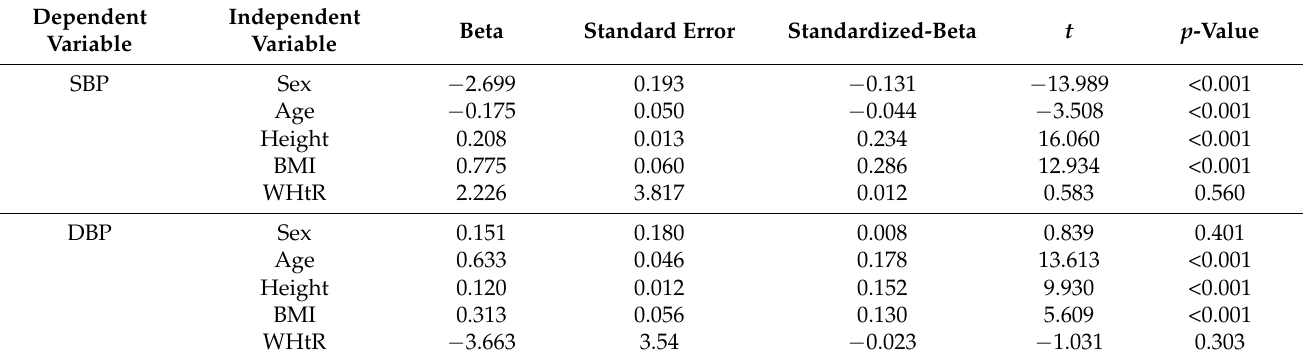
Table 3. Multiple regression analysis for blood pressure.